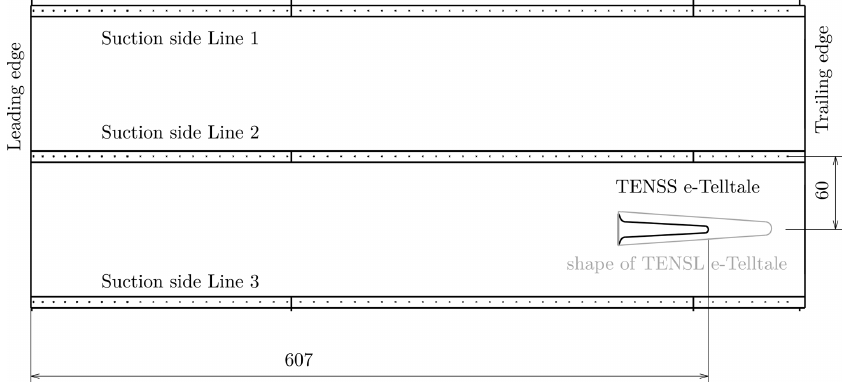
Figure 7. Position of the TENSS e-TellTale.